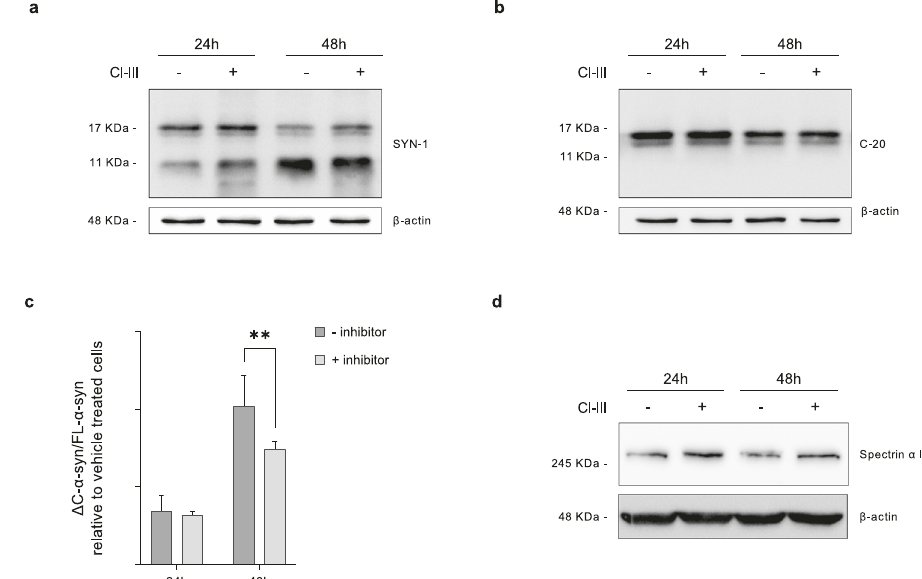
Fig. 5 Effect of Calpain I inhibition on α -syn C-terminal truncated species accumulation in Hb cells. Cell lysates of Hb cells treated with DMSO (-) and Calpain inhibitor III ( + ) were analyzed by immunoblotting with SYN-1 ( a ) and C-20 ( b ) antibodies. Band intensity corresponding to Δ C- α -syn and FL- α -syn was quanti fi ed and the ratio was calculated. Data represent means ± SEM and are representative of six independent experiments. Statistical analysis was performed with one-way Anova. * p ≤ 0.05; ** p ≤ 0.01 ( c ). Cell lysates of Hb cells treated with DMSO (-) and CI-III ( + ) were analyzed by immunoblotting with anti-Spectrin α II antibody ( d